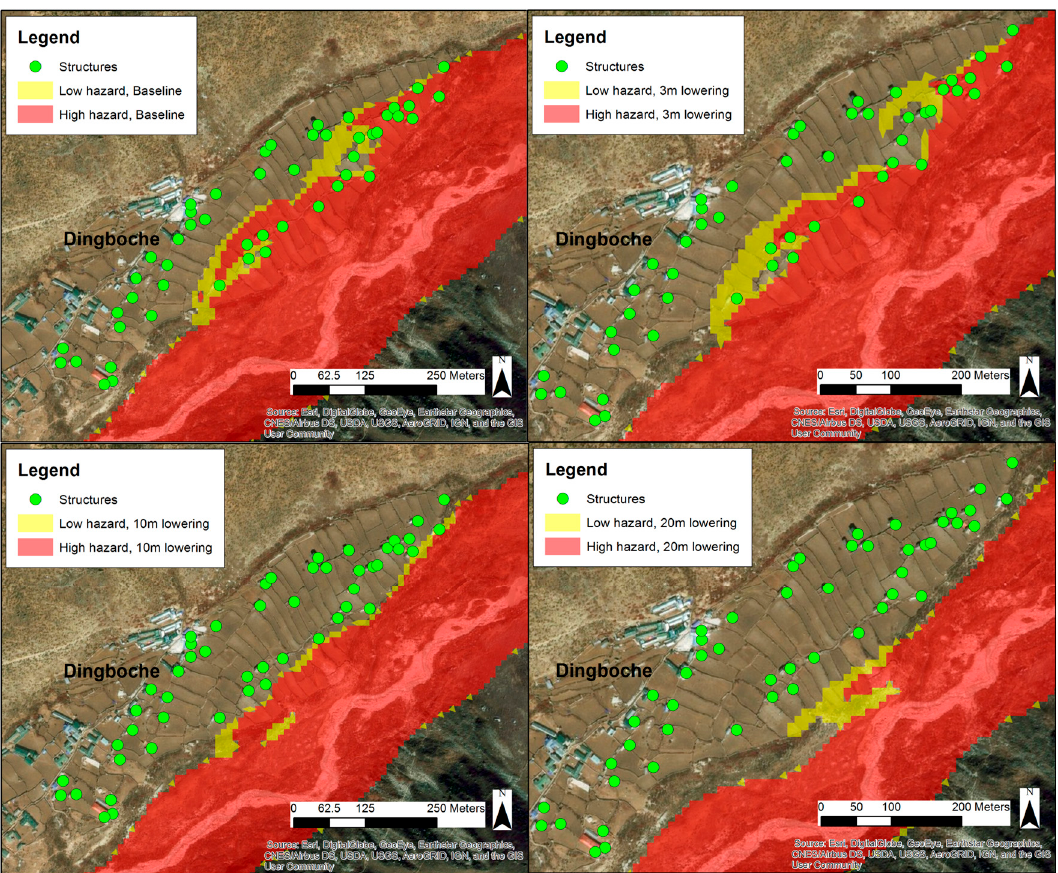
Figure 4. Infrastructure and population inventory in Dingboche identified using satellite imagery and verified by field inventory. Flood intensity regions (high in red and low in yellow) in Dingboche. Clockwise from top left, the images show flood severity for no lowering (business as usual (BAU)), 3 m lowering, 10 m lowering, and 20 m lowering. Table 4. Sample of infrastructure inventory data collected during field inventory in Dingboche.